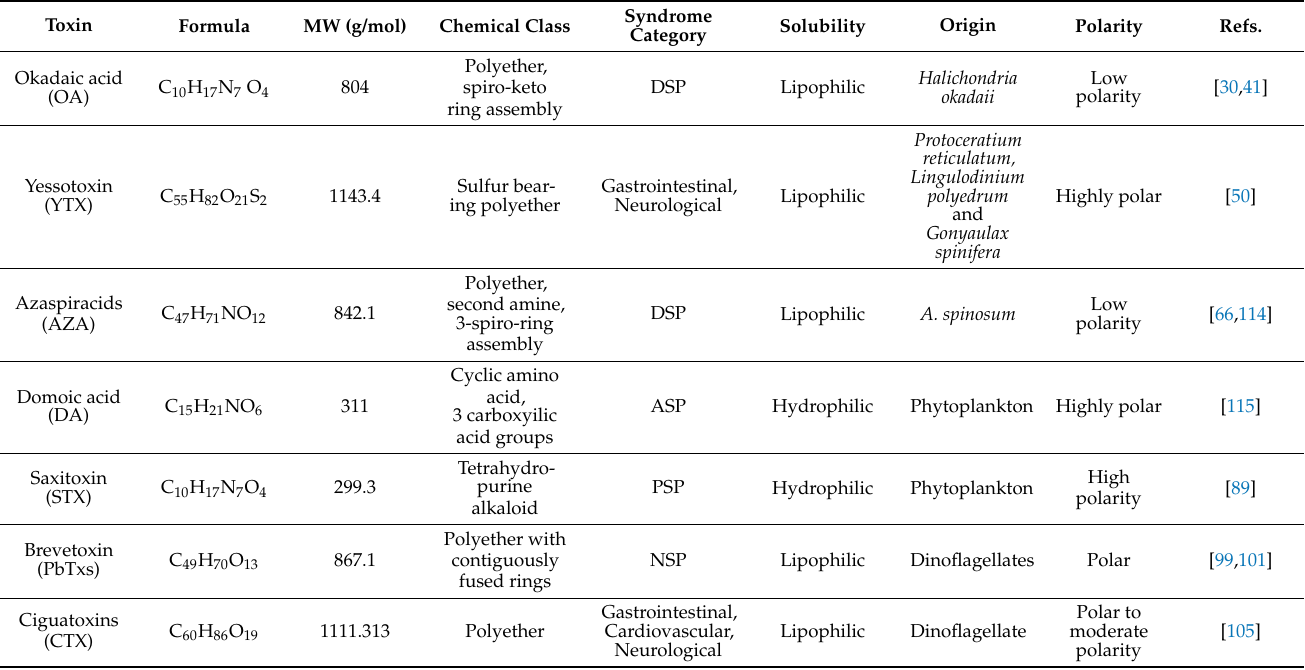
Table 2. Marine biotoxin